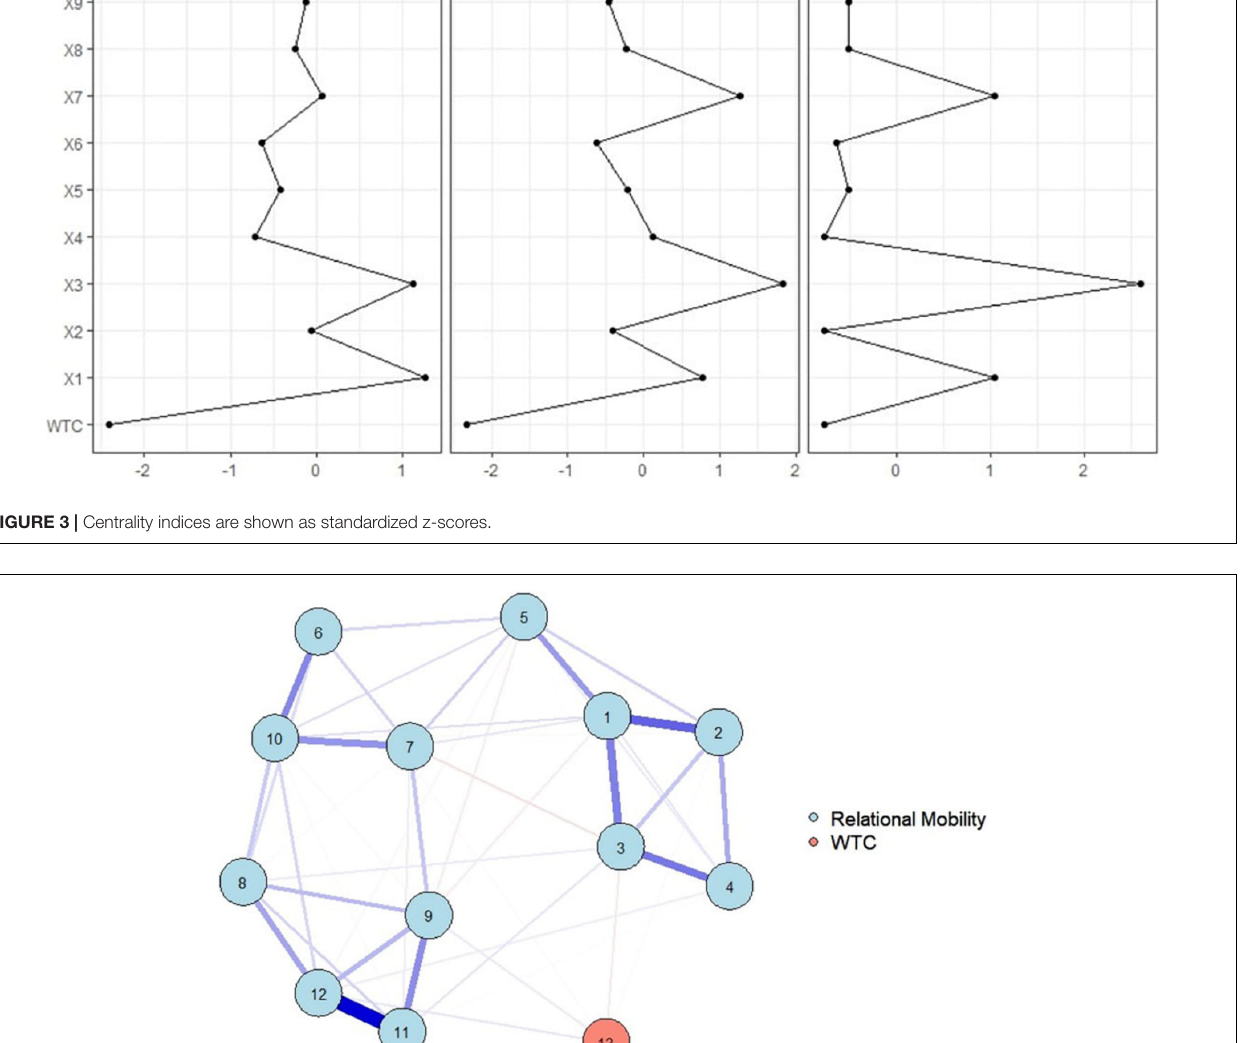
case-dropping bootstrap by the corStability function was